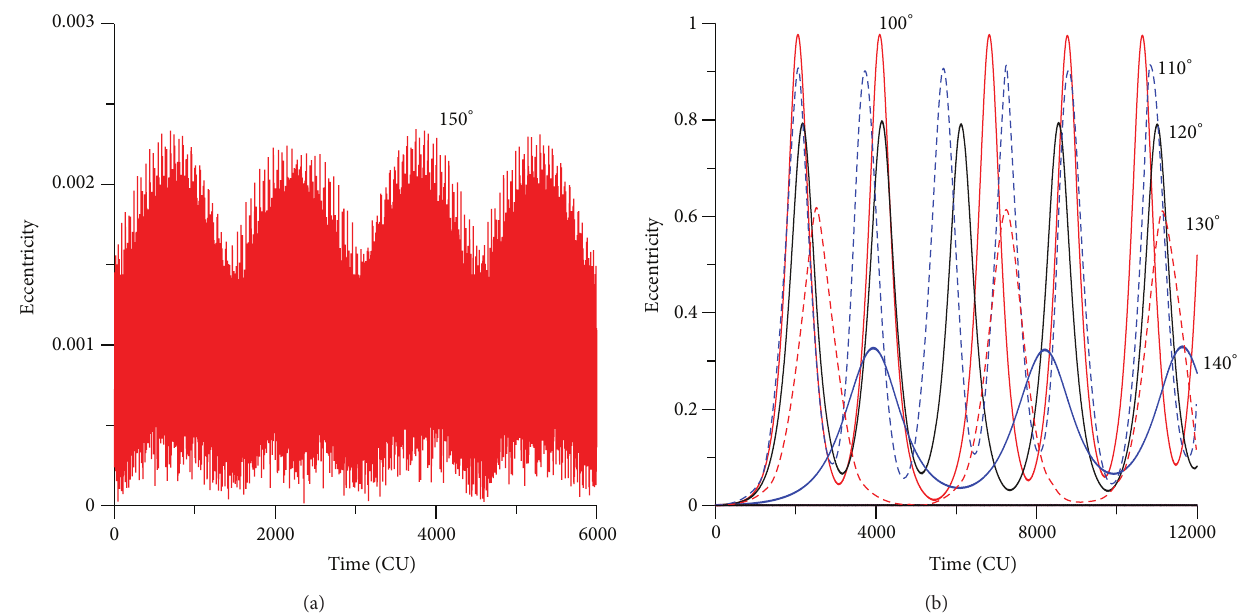
Figure 10: Evolution of the eccentricity for circular and retrograde orbits (exact model). The initial conditions are a = 0.341 canonical units, e (0) = 0, M 0 (0) = 0, 𝜔 (0) = 0, and Ω (0) = 0.